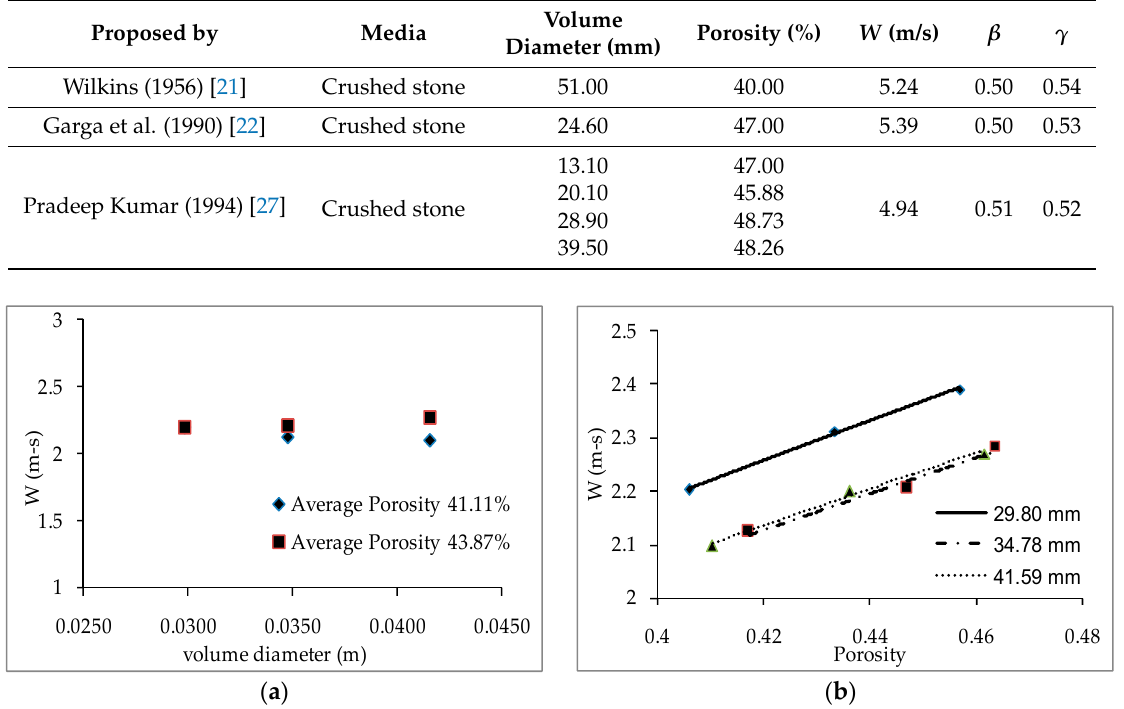
Figure 4. Thevariation of W with ( a ) varying volume diameters of the media with constant porosities and ( b ) with varying porosity with constant media size.